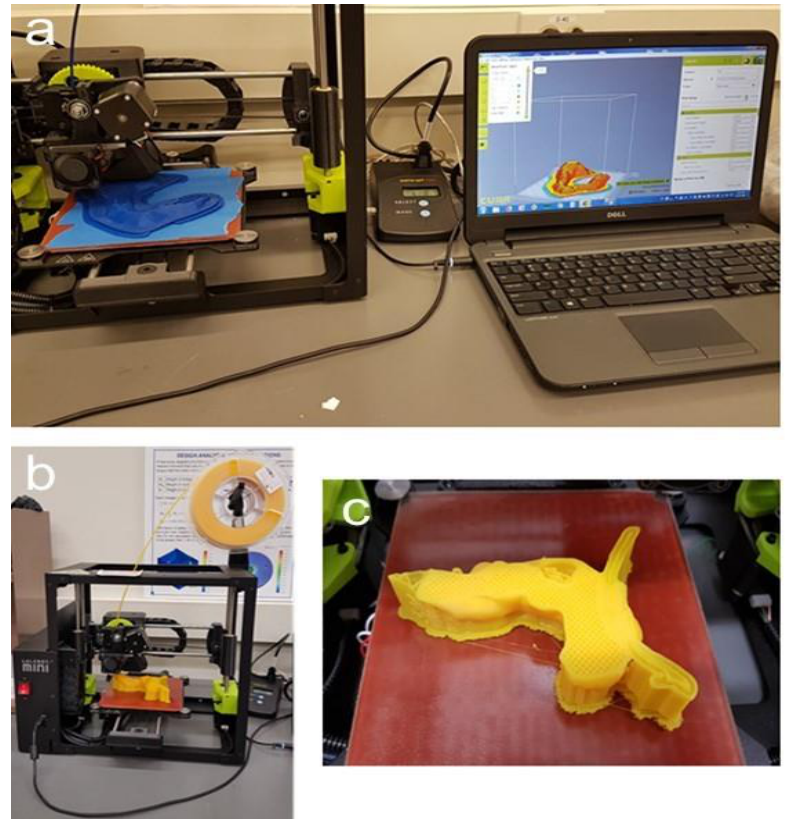
Figure 6. Three-dimensional printing of the replica. ( a ): Printing of the stomach on the Lulzbot Mini with the power meter in the middle and software, Cura, displayed on the computer; ( b ): Lulzbot Mini with filament spool; ( c ): 3D-printed pancreas during the process of printing with stable infill, the supports, the splint, and a cavity at the tumor site where the magnetic field can later be meas- ured.